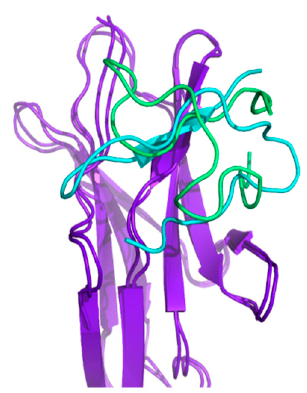
Figure 4. The comparison between the structure of the dominant cluster of HVEM (14–39) peptide docking to BTLA (purple) obtained from (i) simulations with peptide restraints based on the crystal structure (cyan) of the BTLA/HVEM complex and (ii) simulations with peptide restraints based on the structure derived from the nuclear magnetic resonance (NMR) spectra (green).